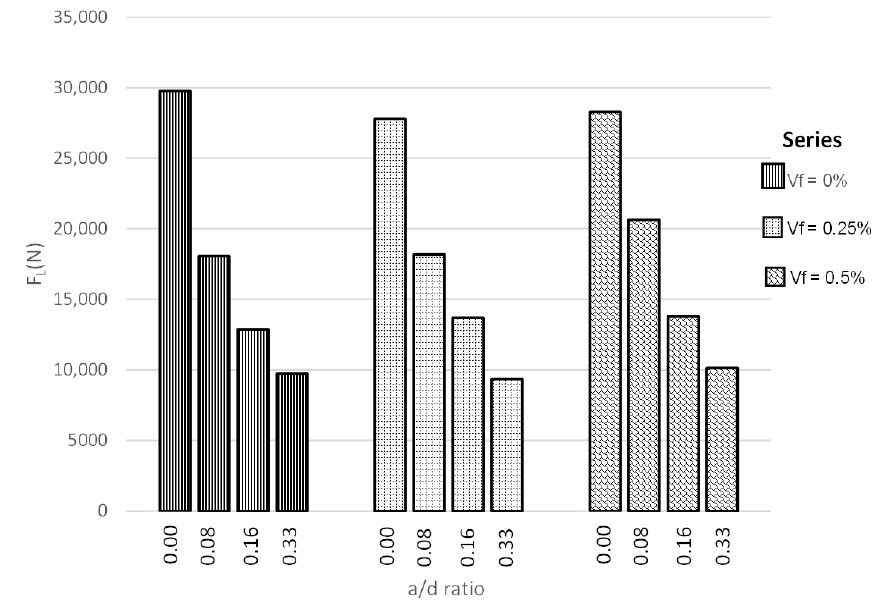
Figure 3. Experimental behavior at the proportional limit.